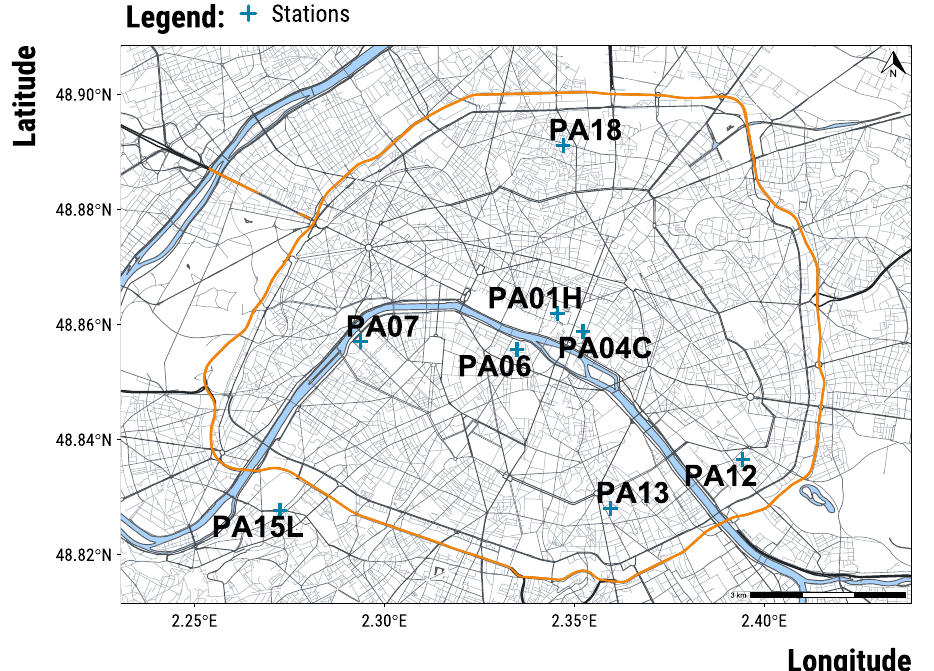
Figure 2. Map of road network and location of air pollution measuring stations in Paris, France . Grey lines represent the road network. The orange line is the orbital ring surrounding Paris. Blue crosses are the locations of air pollution measuring stations. NO 2 concentrations are measured at stations PA07, PA12, PA13, PA18; O 3 concentrations at PA13, PA18; PM 10 at PA18; PM 2.5 at PA01H and PA04C. The map was created with the R programming language (version 4.1.0) 36 , data were provided by OpenStreetMap 37 and retrieved with the 38 osmdata package